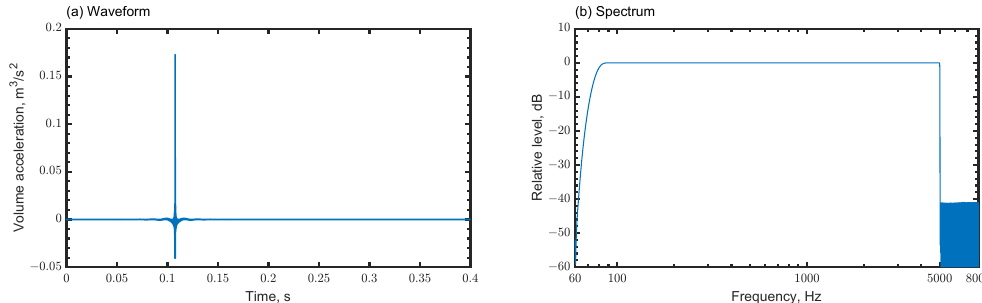
Figure 9. Source signal: ( a ) waveform and ( b )